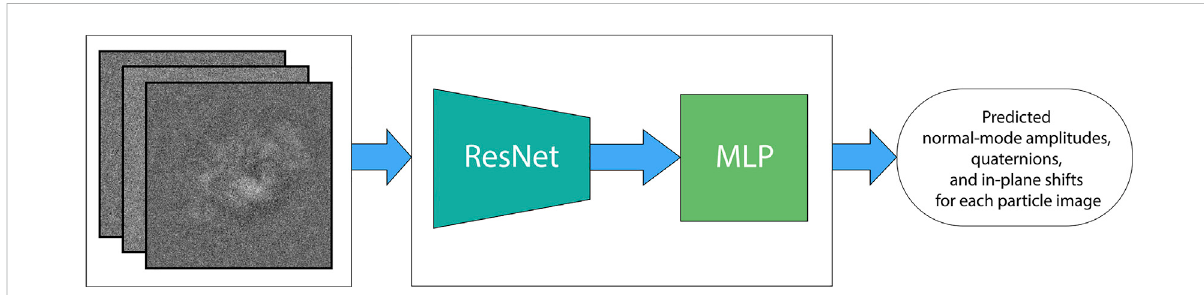
FIGURE 3 DeepHEMNMAneuralnetworkstep.ThedeeplearningneuralnetworkisacombinationofaResNet34featureextractor(ResNetblock)anda4- layermultilayerperceptron(MLPblock).Itistrainedtomapeachsingle-particleimageontothecorresponding,HEMNMA-estimatedconformational parameters(Mnormal-modeamplitudes),orientationalparameters(3Eulerangles),andpositionalparameters(2in-planeshifts)oftheparticleinthe image. DeepHEMNMA converts the Euler-angle representation of the orientation used in HEMNMA into a 4-parameter quaternion representation,whichislearnedbytheneuralnetwork internally. The learnedquaternionrepresentation oftheorientation isthenconvertedbackto the Euler-angle representation for the analysis at Stage 3 of